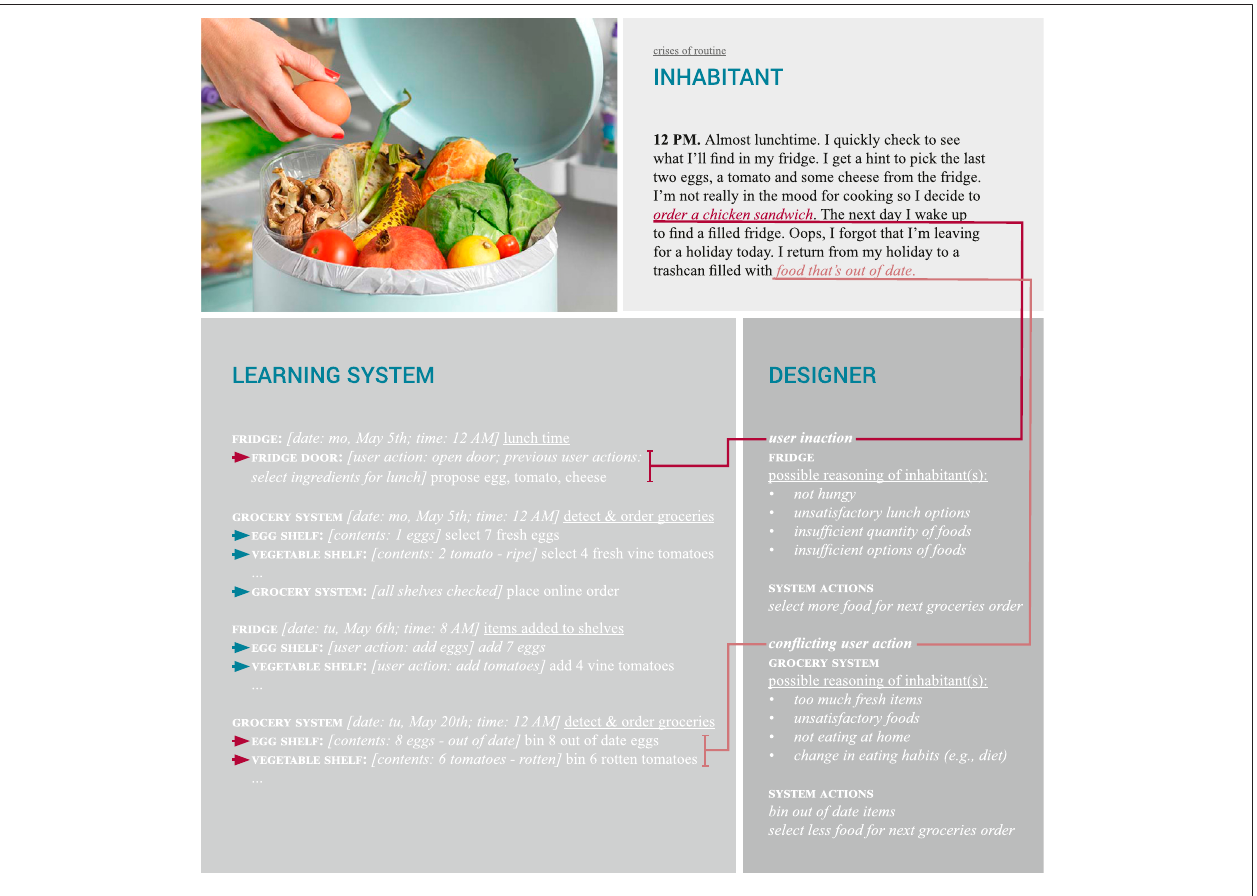
FIGURE 4 | Groceries: crises imaginary (photo by Dazeley,